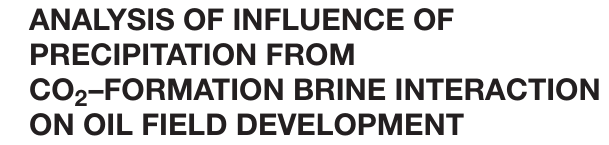
TABLE 5 | Model parameters.